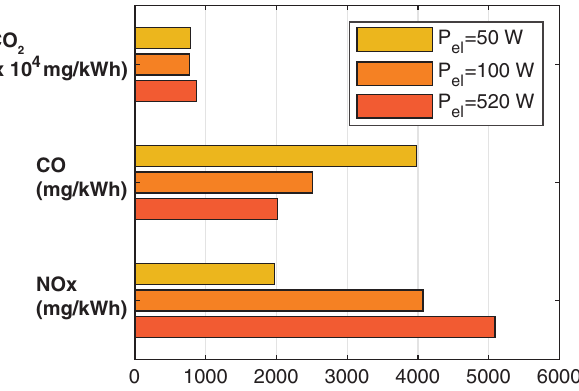
Figure 17. Emissions in the exhausts of TEGs of different size operating in nominal conditions.